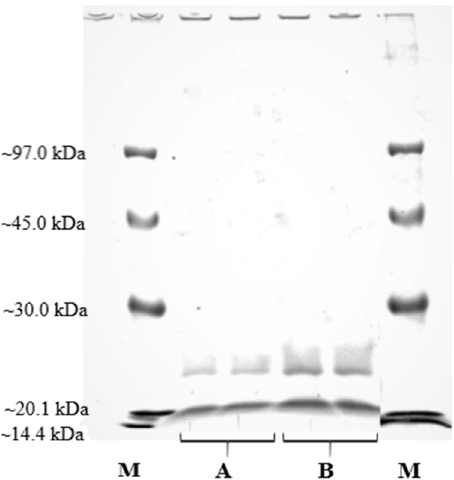
Figure 3. SDS-Page of A. japonicus lipase produced by submerged culture. The columns represent: M: molecular weight markers (14.4–97 kDa). A: culture media containing A. japonicus lipase at 155.2 mg mL − 1 ; B: culture media containing A. japonicus lipase at 257.2 mg mL − 1 .